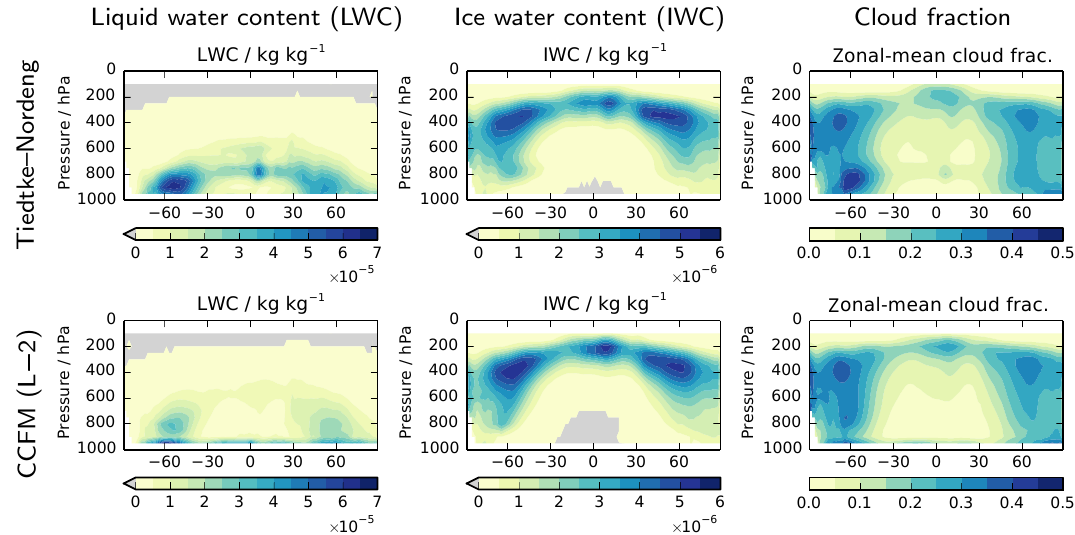
Figure 3. Annual and zonal mean (from left to right) liquid water content (LWC), ice water content (IWC) and cloud fraction from 30-year AMIP-type simulations using ECHAM–HAM with Tiedtke–Nordeng and CCFM (L − 2) convection.